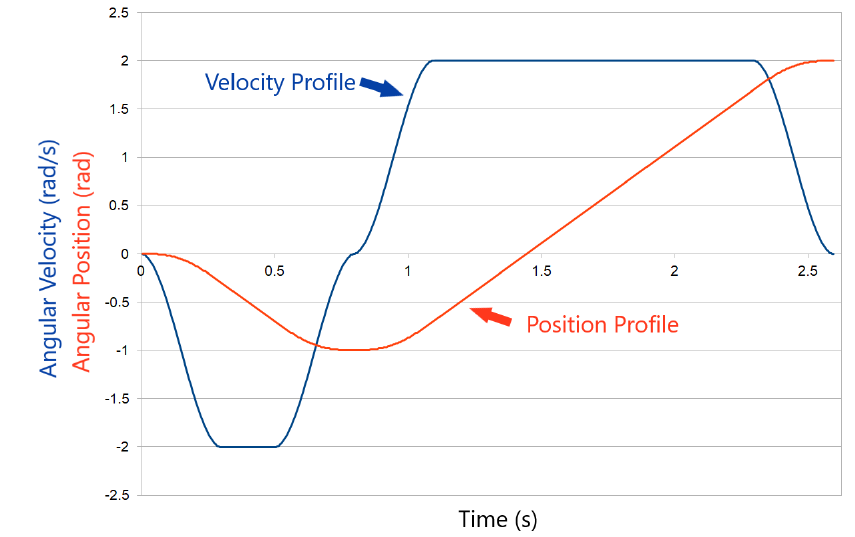
Figure 3. Profiles Examples.